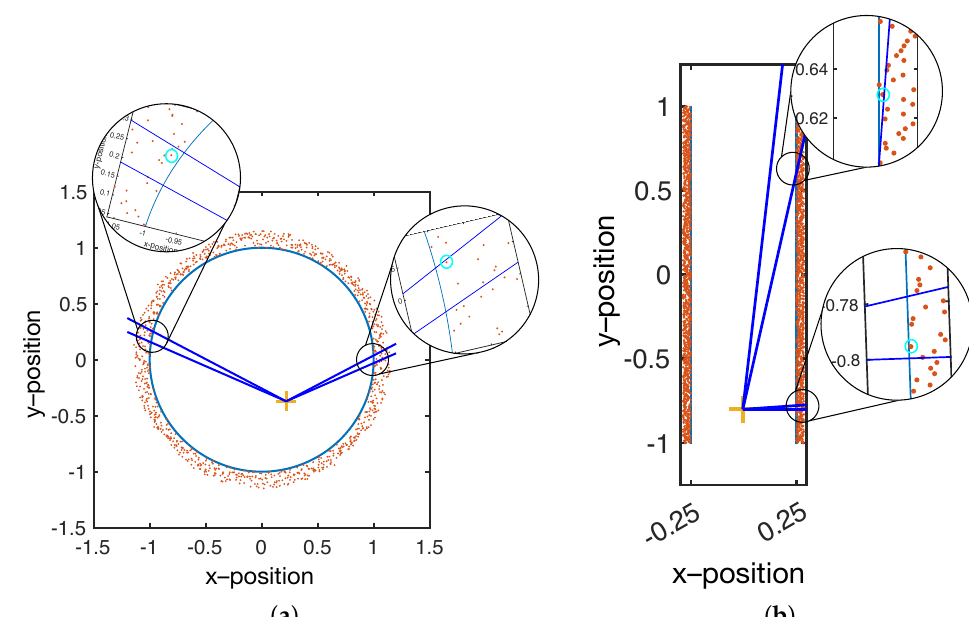
Figure 3. Single reference point in a spherical volume ( a ). Within the angular resolution (dark blue lines), only the point closest to the reference point (highlighted by the cyan circles in the insets) are passed on for visualization. With a near–spherical object, the areal density of points after filtering is nearly constant. Single reference point in a cylindrical volume ( b ). As with the case for the spherical volume, only the closest point to the reference point is selected. However, for some locations, the areal density of points is significantly reduced. In addition, due to the highly oblique angle, the selected point is not necessarily close to the surface (cyan circle top